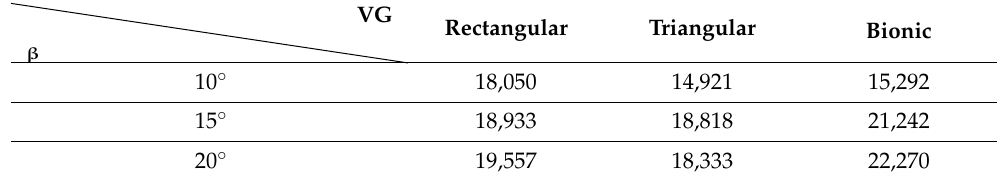
Table 1. Table of the integration values of the harmonic intensity coefficients on the coordinate axes. VG Rectangular Triangular Bionic β 10 ◦ 18,050 14,921 15,292 15 ◦ 18,933 18,818 21,242 20 ◦ 19,557 18,333